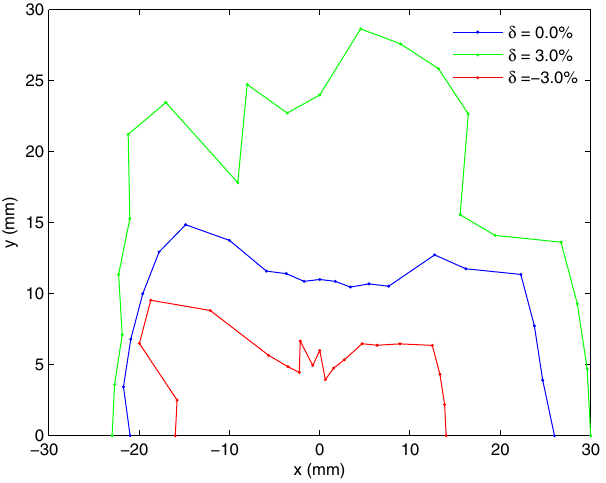
FIG. 3. Dynamic aperture for Diamond (bare lattice) at the injection point for different off-energy values.